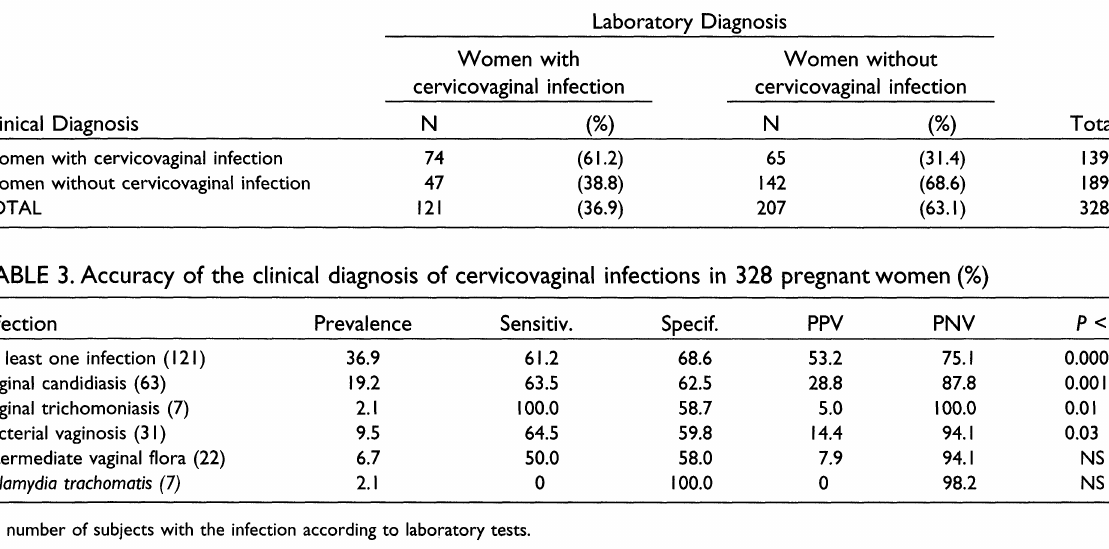
TABLE 2. Cervicovaginal infections according to laboratory confirmation of the clinical diagnosis